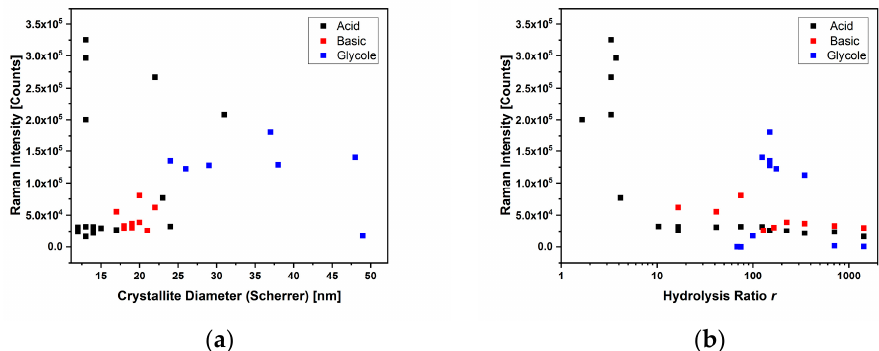
Figure 10. The plots correlate the Raman peak intensity with the crystallite diameter ( a ) and hydrol- ysis ratio ( b ) for all syntheses: acid (black squares), basic (red squares) and with glycol (blue squares).